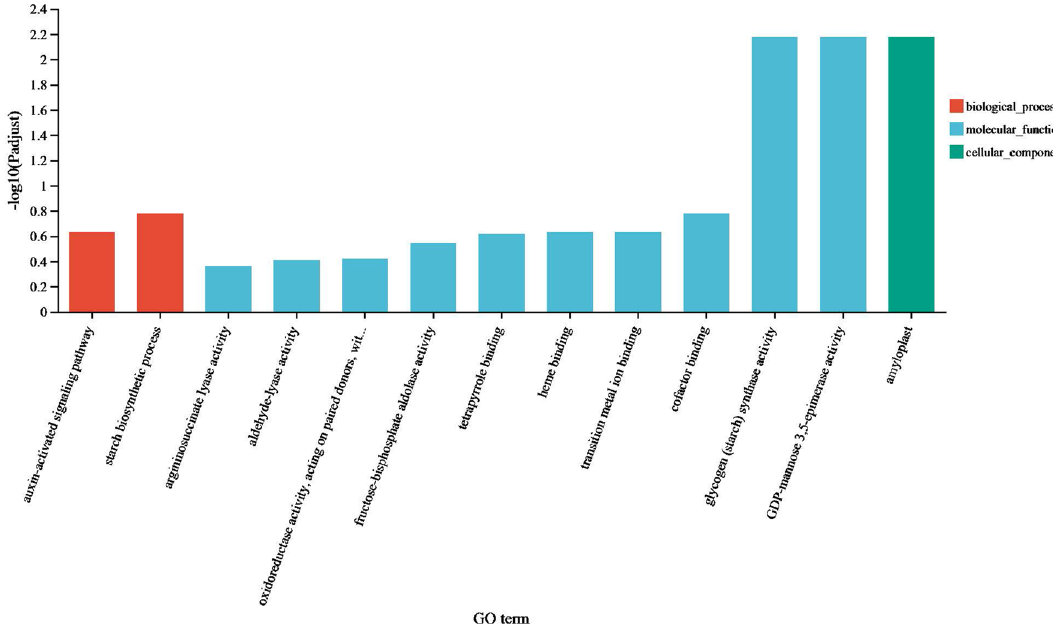
Figure 9. Go analysis of intersection of DEGs between rootstocks and scions of two grafted groups.